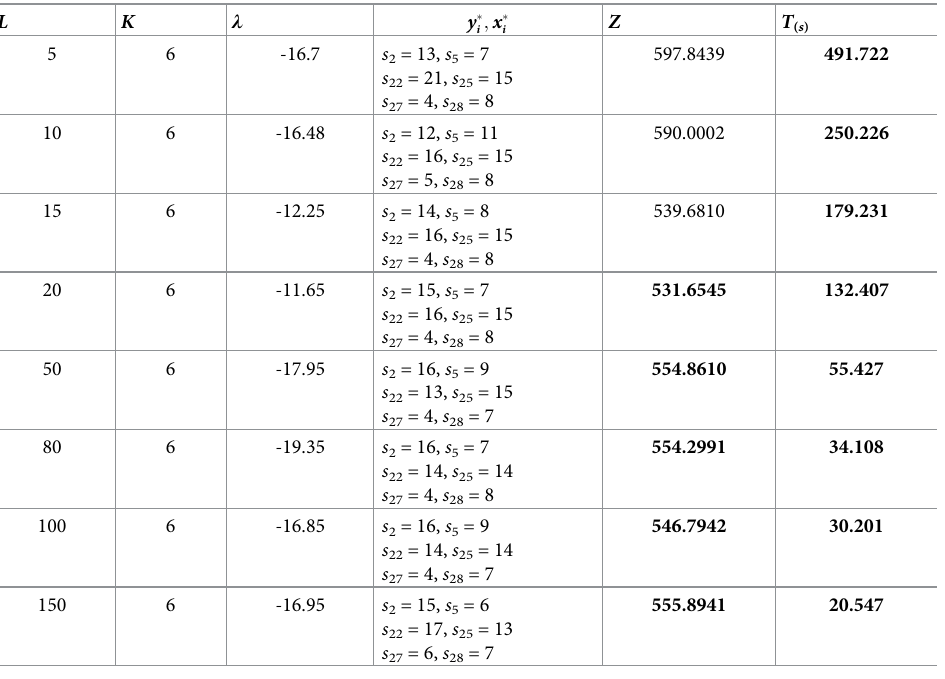
Table 4. Sensitivity analysis of Dow Jones shares.